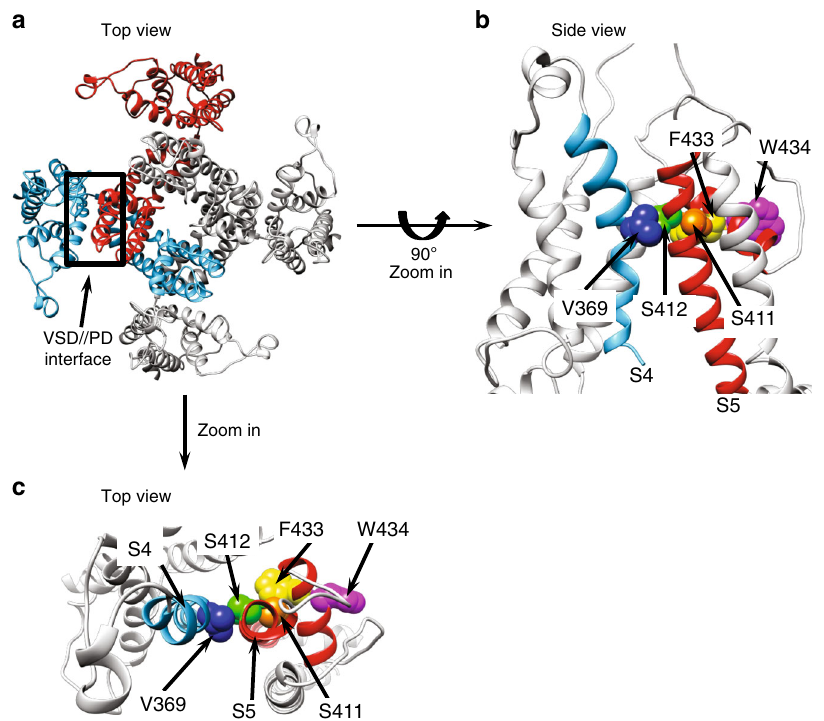
Fig. 7 Structural models of a Shaker-like channel (K V 1.2, PDB:3LUT), showing the suggested VSD//PD interface. a Top view of the tetrameric channel, with two subunits in blue and red colors and the other two, for clarity, in light gray. Notice that the black square region indicates the VSD//PD interface between the VSD from different blue and red neighboring subunits. b Black square region from a zoomed in and turned by 90°. The cartoon shows with ribbons the S4 segment from one subunit in blue and the S5 segment from the neighbor subunit in red. Colored spheres are the van der Waals volumes of the atoms from the residues indicated (V369 in blue, S412 in green, S411 in orange, F433 in yellow, and fi nally W434 in magenta (residues numbering as in Shaker)). These residues are proposed to be the physical connection of the noncanonical coupling pathway between VSD and PD. c Top view of the zoomed black square region shown in a . Color code and labels correspond to a . Note that in a and in b the van der Waals surfaces are in contact, giving support to the hypothesis of the VSD//PD